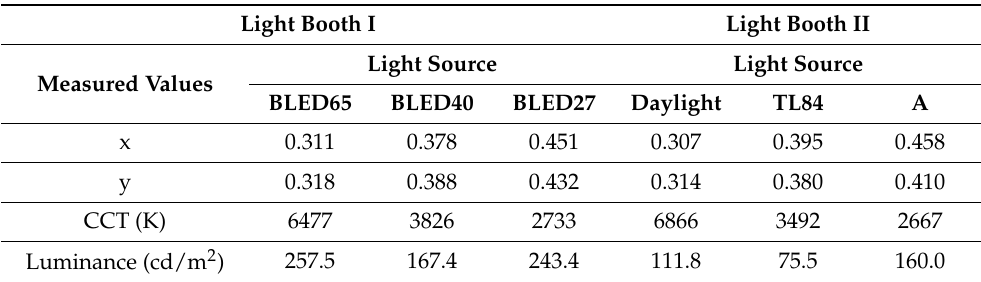
sources with nominal CCT 6500 K, 4000 K, and 2700 K respectively for light booth